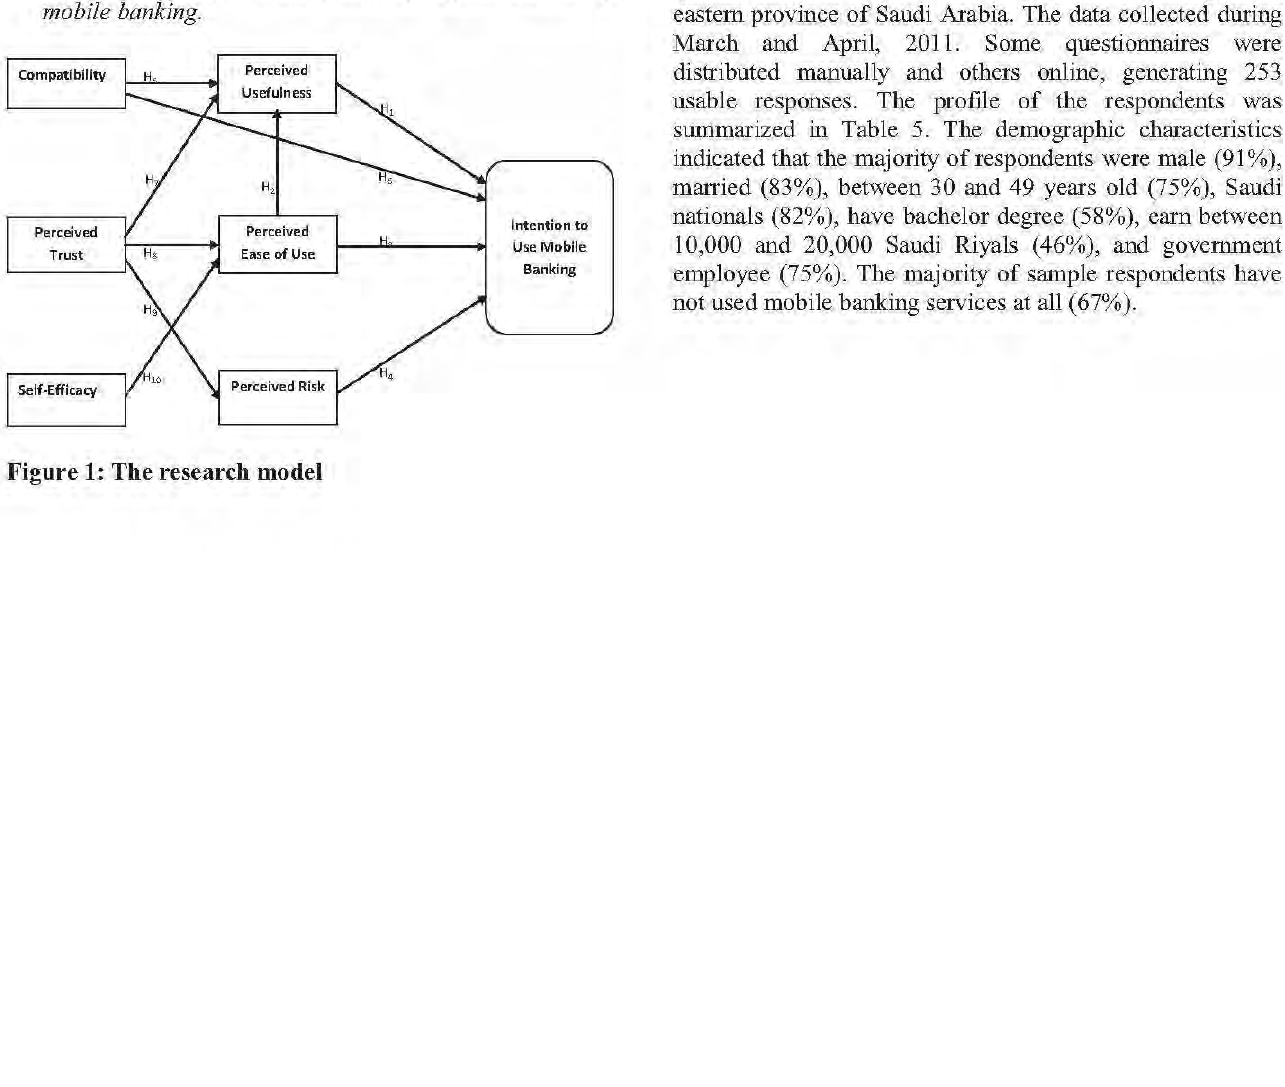
Figure 1: The research